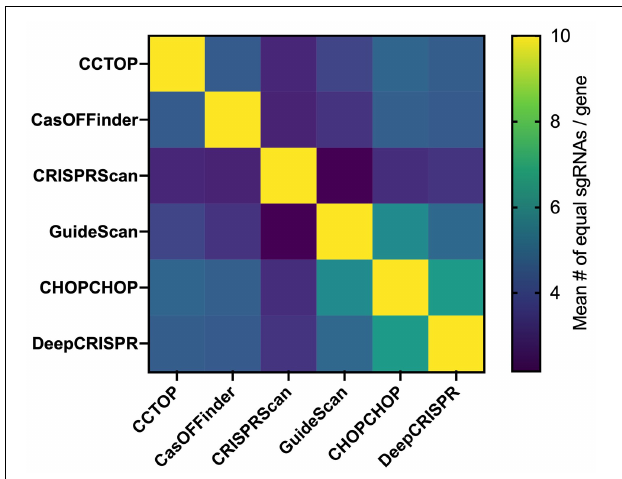
FIGURE 3 | sgRNA choice comparison between available online tools. Using a total set of 36 exons from different genes with an average size of 386 ± 530 bp (list below), the top 10 sgRNA of the CCTop, CasOFFinder, CRISPRScan, GuideScan, CHOPCHOP, and DeepCRISPR were determined. Afterward, the common top sgRNAs between any two tools were identified for each, and the mean number of common guides is shown in the matrix based on a heatmap. Each square represents the comparison of the corresponding horizontal and vertical position. The different choice of sgRNAs between the available tools for a given genomic region target is associated to the choice of different collections of potential off-targets. The list of genes used: SPHK1 (Hs), SPHK2 (Hs), IL7RA (Hs), IDE (Hs), HLA (Hs), BLM (Hs), GUSB (Hs), AZIN1 (Hs), ADRA2C (Hs), ADRB2 (Hs), MAPT (Hs), SMAD3 (Hs), EIF2AK4 (Hs), MVK (Hs), Anxa1 (Mm), Adra2c (Mm), KLHL (Hs), Mlh1 (Mm), Msh6 (Mm), KRAS (Hs), DHX37 (Hs), RYR2 (Hs), NR3C1 (Hs), ODF2 (Hs),